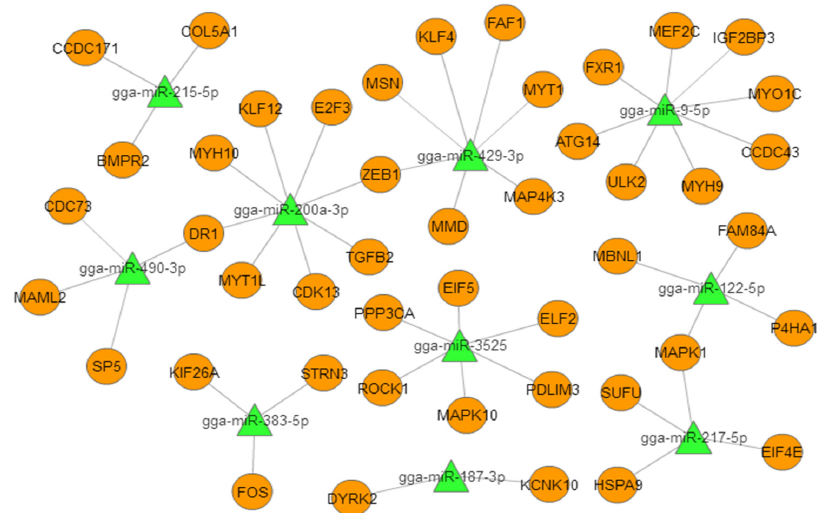
Figure 3. Proposed miRNA–mRNA interaction network of the 10 most abundant differentially expressed miRNAs (DEMs) with their potential target mRNAs. The miRNAs are represented by green triangles and targets are represented by orange circles.